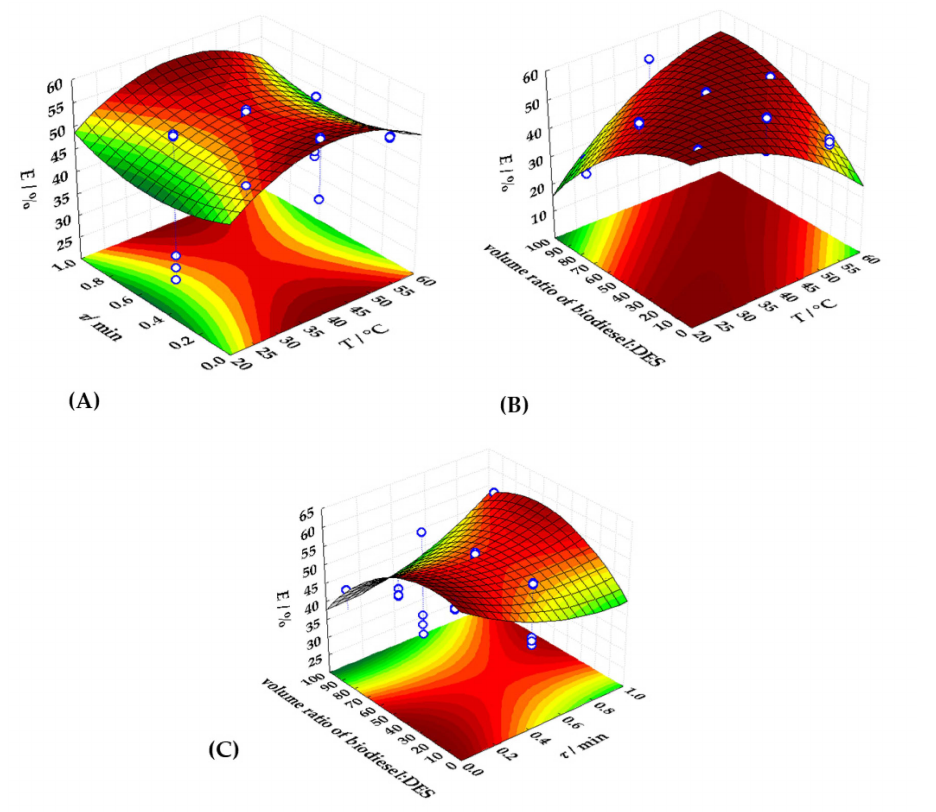
Figure 5. Three dimensional response surface plot for the interaction between ( A ) extraction temper- ature and residence time, ( B ) extraction temperate and biodiesel:DES volume ratio and ( C ) residence time and biodiesel:DES volume ratio.